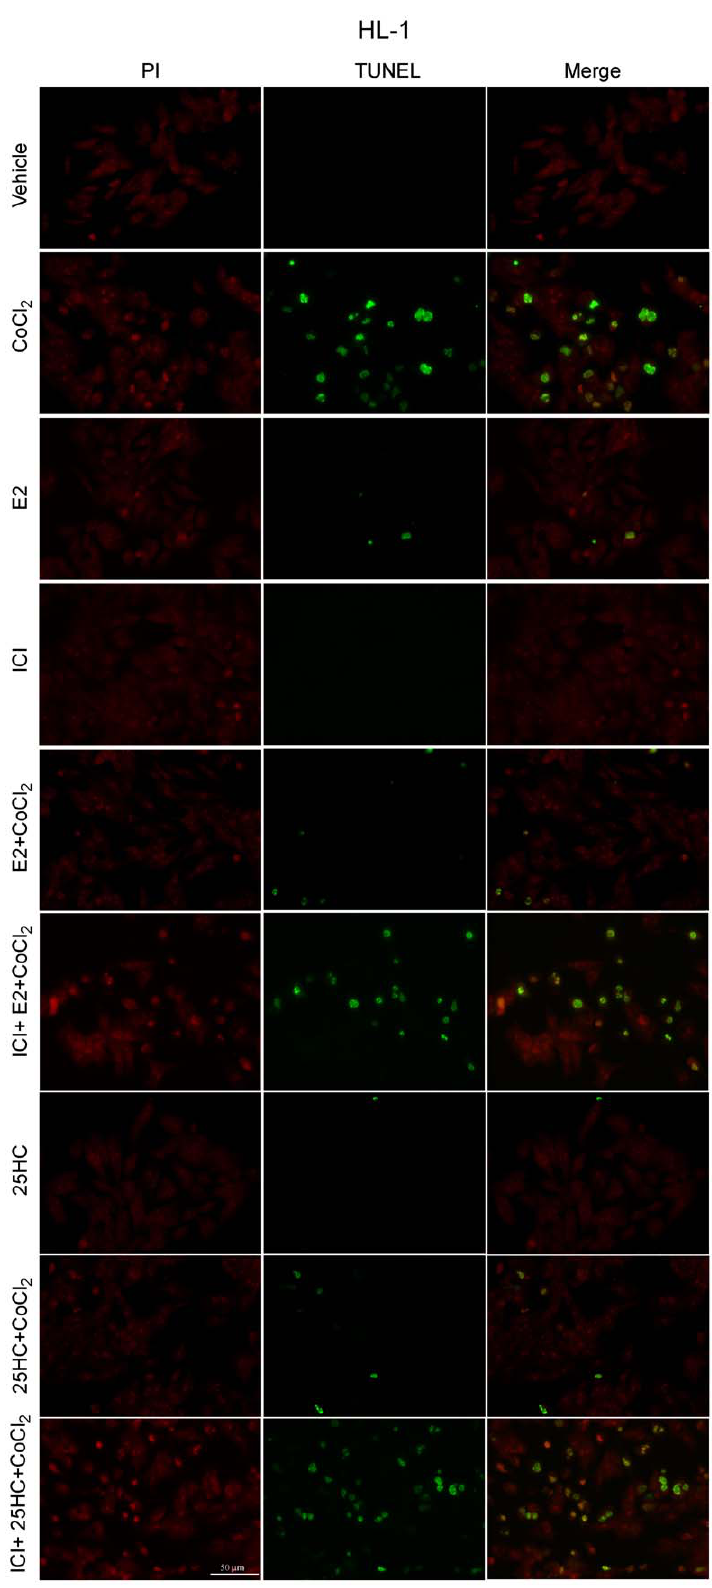
Figure 5. E2 and 25HC prevent CoCl2-induced apoptosis in HL-1 cells. Apoptotic changes were detected using TUNEL (in green) and nuclei were stained by propidium iodide (PI, in red), as indicated. Representative photographs after 18h treatment with vehicle and 100 m M CoCl2, 10nM E2, 1 m M 25HC alone, or a combination of 100 m M CoCl2 with 10nM E2 in presence or absence of 10 m M ICI, 100 m M CoCl2 with 1 m M 25HC in presence or absence of 10 m M ICI. doi:10.1371/journal.pone.0016631.g005 PLoS ONE |